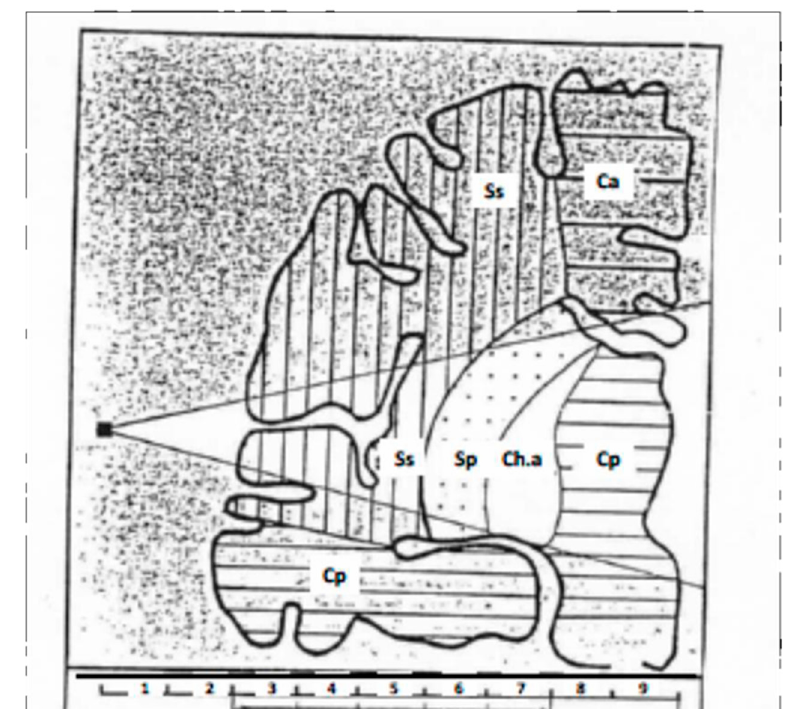
Figure 3. Hypothesis regarding the different neuro-vascular temporal territories included, from surface to depth, in the ultrasound field [26]. Ca, anterior cerebral artery territory; Cp, posterior cerebral artery territory; Ch.a, anterior choroidal artery territory; Sp, deep Sylvian territory; Ss, Superficial Sylvian territory.